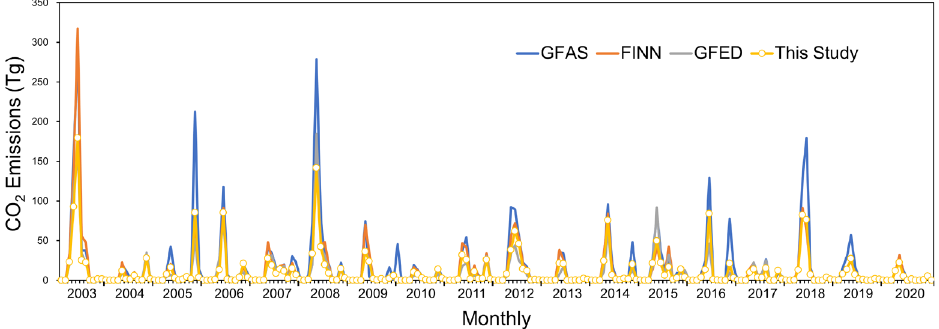
Figure 7. Monthly mean CO 2 emissions (Tg) from OBB in this study compared with GFED, FINN and GFAS data for 2003–2020. and GFAS data for